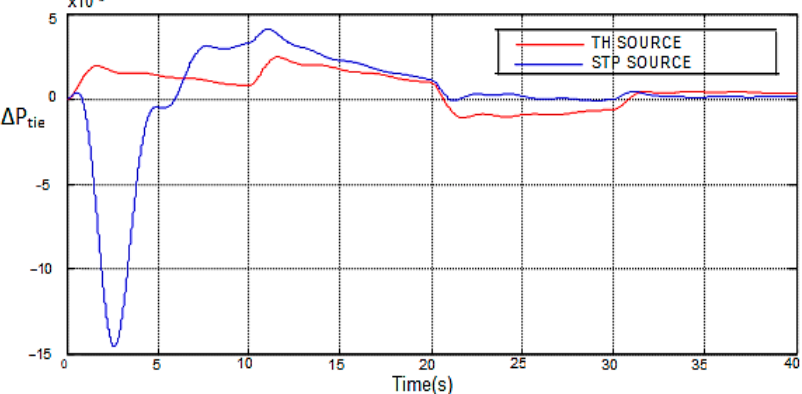
Figure 16. Power flow fluctuations in tie line without and with STP and variable SLP.